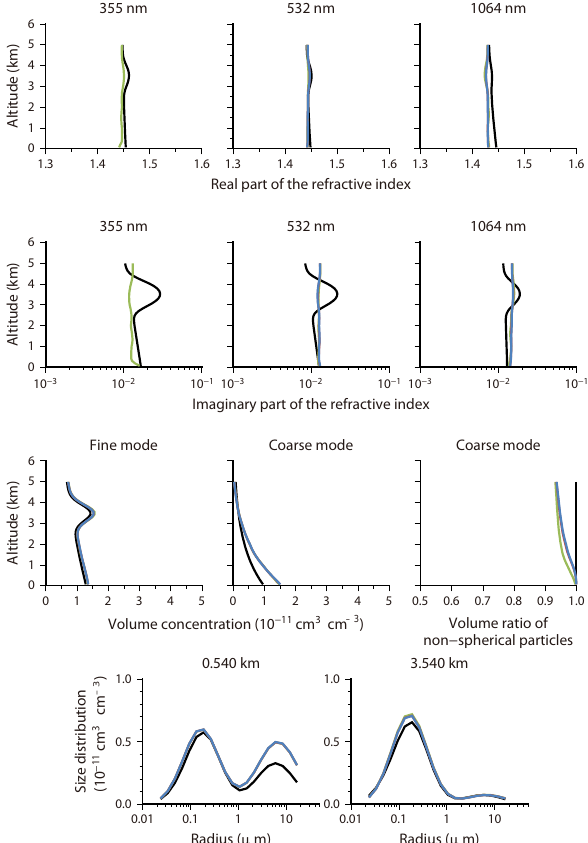
Figure 12. Retrieval results from the simulated data for the trans- ported pollution aerosol: the real and imaginary parts of the refrac- tive index, the volume concentrations of the fine and coarse modes, the volume ratio of the non-spherical particles to total particles in the coarse mode, and the size distributions at two altitudes. “True” values are shown by the black lines, the colored lines indicate re- trievals from Type 1 data set (MIEL data at 532 and 1064nm) (blue), Type 2 data set (MIEL data at 532 and 1064nm; HSRL data at 532nm) (red), and Type 3 data set (MIEL data at 532 and 1064nm; HSRL data at 355 and 532nm) (green). The red and blue lines completely overlap.